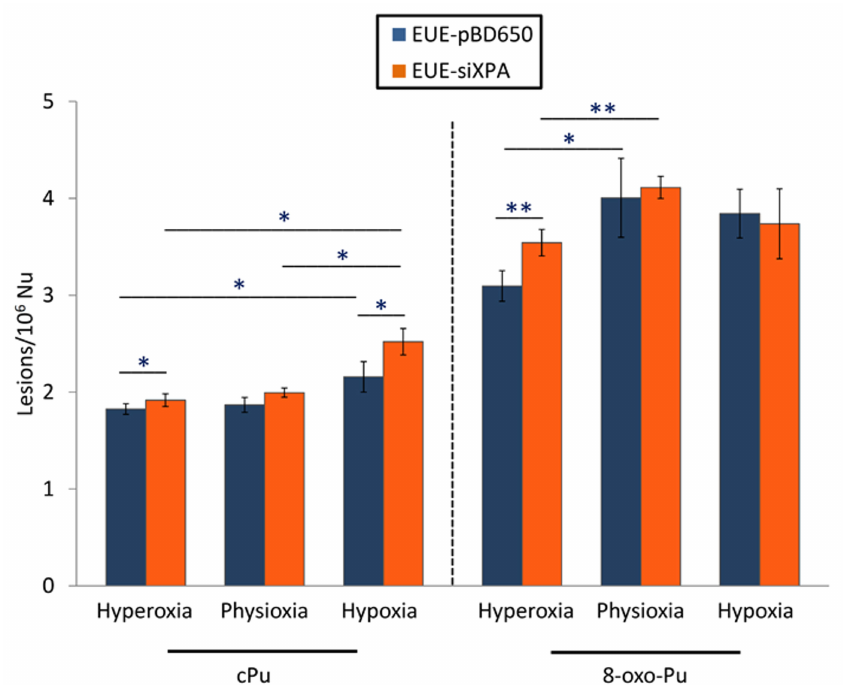
Figure 4. The levels (lesions / 10 6 nucleosides) of sum of cyclopurine and 8-oxo-purine lesions in DNA isolated from EUE-pBD650 (wt) and EUE-siXPA (deficient) cells in in hyperoxic, physioxic and hypoxic conditions. Error bars: standard deviation of the mean, calculated from three independent samples, *: statistically significant di ff erence ( p < 0.05) between the groups, **: statistically significant di ff erence ( p < 0.005) between the